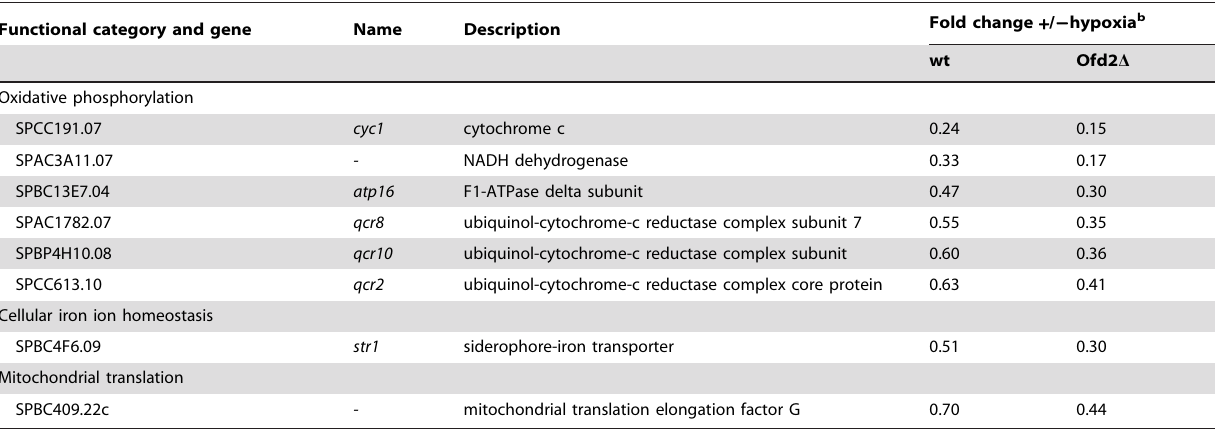
Table 1. Significantly a hypoxia repressed genes in Ofd2 D